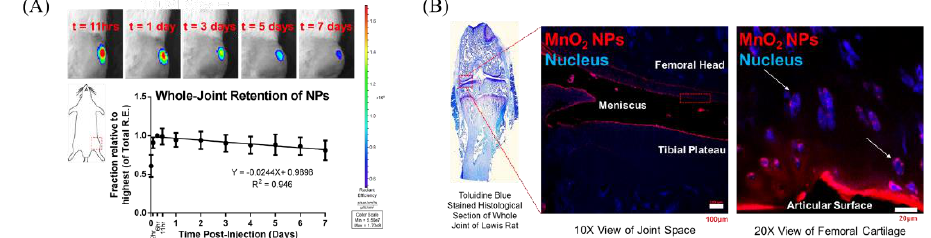
Figure 3. Retention and Uptake of MnO 2 NPs in vivo. ( A ) After in vivo injection in articular joints of Lewis Rats, Alexa Fluor 750 labeled MnO 2 NPs persisted in the joint for at least 7 days (n = 6) ( B ) The Alexa Fluor 594 labelled MnO 2 NPs within knee joint 2 days post-injection in a histological sample was distributed in the chondral surfaces (scale bar = 100 < m in 10X view and 20 < m in 20X view) with white arrows indicating uptake of NPs by resident chondrocytes in the femoral